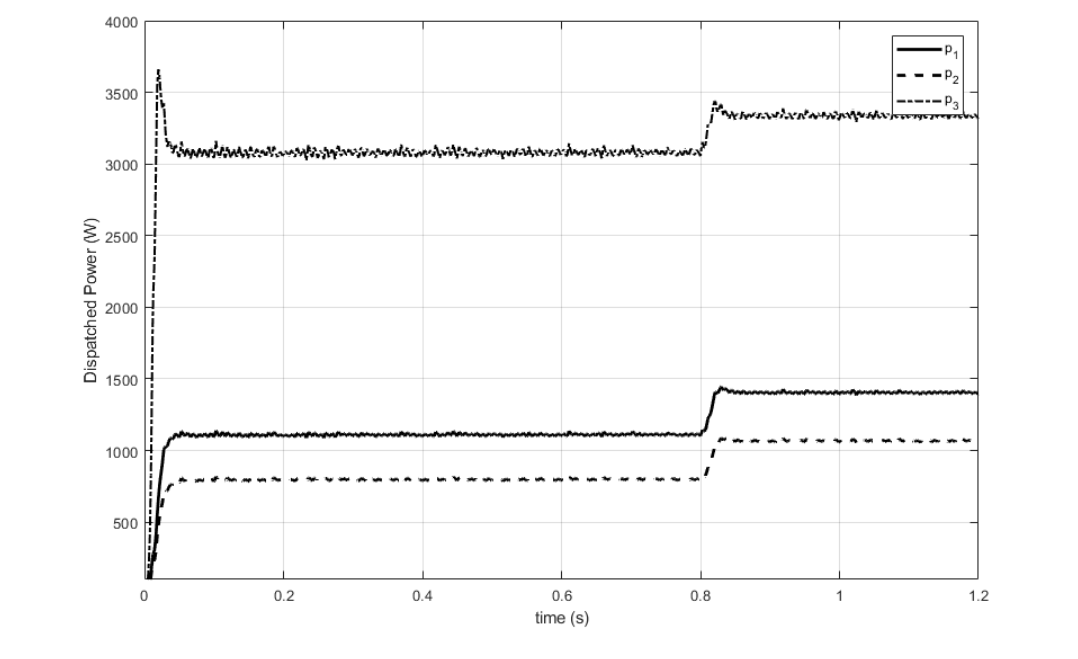
Figure 4. Power response of each DG.